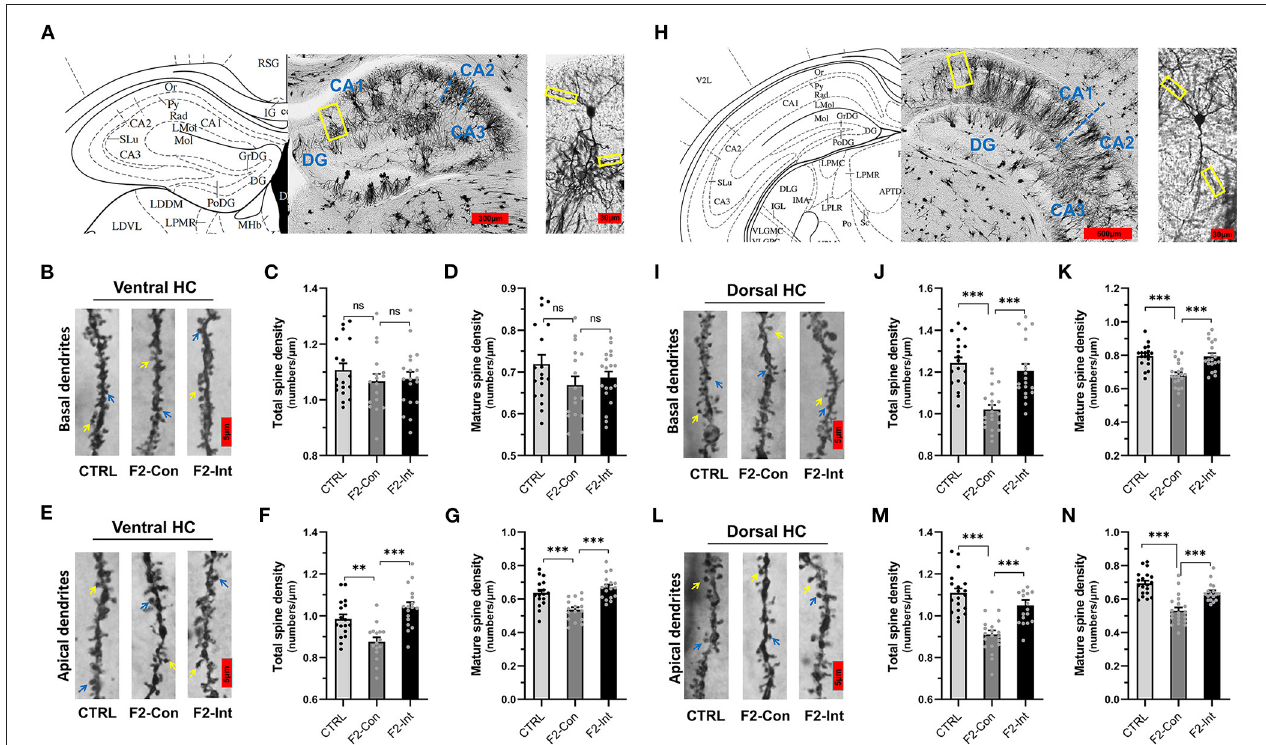
FIGURE 6 | Prenatal baclofen administration corrected the defects in dendritic spines density of CA1 pyramidal neurons in the HC in F2 mice. (A) A composite of a representative scanned image of Golgi-Cox-stained slices of the ventral HC and the mouse brain map from The Mouse Brain in Stereotaxic Coordinates ; scale bar: 300 and 30 µ m. (A/H) The part inside the yellow rectangle is the neurons and dendrites selected for analysis. The spines were selected from grade 3 basal dendrites and grade 6/7 apical dendrites for analysis. (B/E) Representative three-dimensional reconstructed images of the basal/apical dendrites of pyramidal neurons in the CA1 of the ventral HC obtained from CTRL, F2-Con and F2-Int mice. The yellow arrow points to a mushroom spine, and the blue arrow points to a stubby spine. Scale bar: 5 µ m. (C,D) Summary of spine density on the basal dendrites of CA1 pyramidal neurons in the ventral HC. Mature spines = mushroom spines + stubby spines (CTRL: n = 18 dendrites from 3 mice; F2-Con: n = 17 dendrites from 3 mice; F2-Int: n = 19 dendrites from 3 mice). (F,G) Summary of spine density on the apical dendrites of CA1 pyramidal neurons in the ventral HC. Mature spines = mushroom spines + stubby spines (CTRL: n = 17 dendrites from 3 mice; F2-Con: n = 16 dendrites from 3 mice; F2-Int: n = 17 dendrites from 3 mice). (H) A composite of a representative scanned image of Golgi-Cox-stained slices of the dorsal HC and the mouse brain map from The Mouse Brain in Stereotaxic Coordinates ; scale bar: 500 and 30 µ m. (I/L) Representative three-dimensional reconstructed images of the basal/apical dendrites of pyramidal neurons in the CA1 of the dorsal HC. The yellow arrow points to the mushroom spine, and the blue arrow points to the stubby spine. Scale bar: 5 µ m. (J,K) Summary of spine density on the basal dendrites of CA1 pyramidal neurons in the HC (CTRL: n = 18 dendrites from 3 mice; F2-Con: n = 21 dendrites from 3 mice; F2-Int: n = 19 dendrites from 3 mice). (M,N) Summary of spine density on the apical dendrites of CA1 dorsal neurons in the dorsal HC. Mature spines = mushroom spines + stubby spines (CTRL: n = 19 dendrites from 3 mice; F2-Con: n = 20 dendrites from 3 mice; F2-Int: n = 17 dendrites from 3 mice). One-way ANOVA followed by the Bonferroni post-hoc test was used to compare the differences among the four groups; * p < 0.05, ** p < 0.01, *** p < 0.001. All data for all figures are plotted as the mean ±